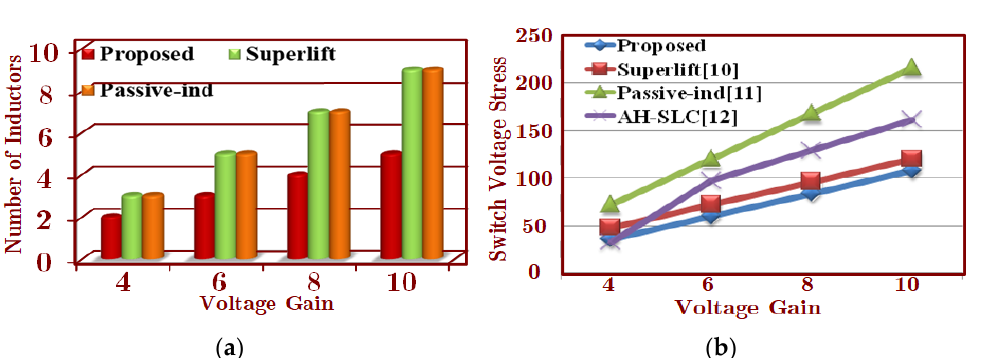
Figure 12. Comparative analysis: ( a ) Voltage gain vs. number of inductors. ( b ) Voltage gain vs. Voltage stress across the switch (S). Table 4. Comparison of HSIVL converter with few high gain converters in the literature .